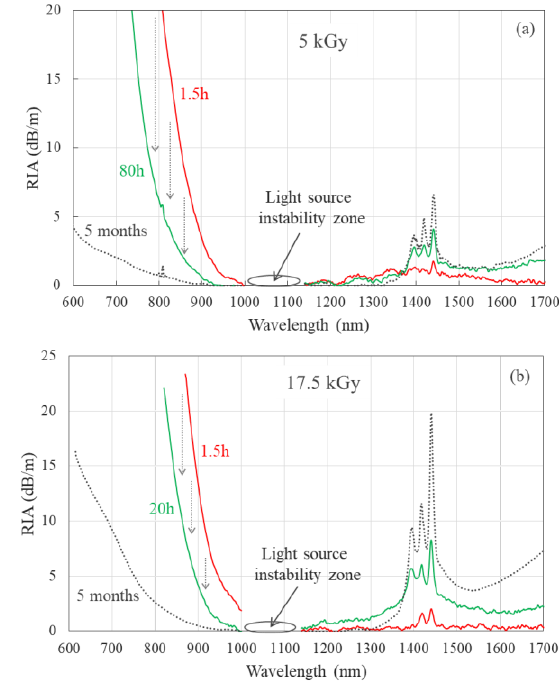
Fig. 6. RIA measured 1.5 h, 80 h and 5 months after irradiation for 5 kGy dose (a) and 1.5 h, 20 h and 5 months after irradiation for 17.5 kGy dose (b).